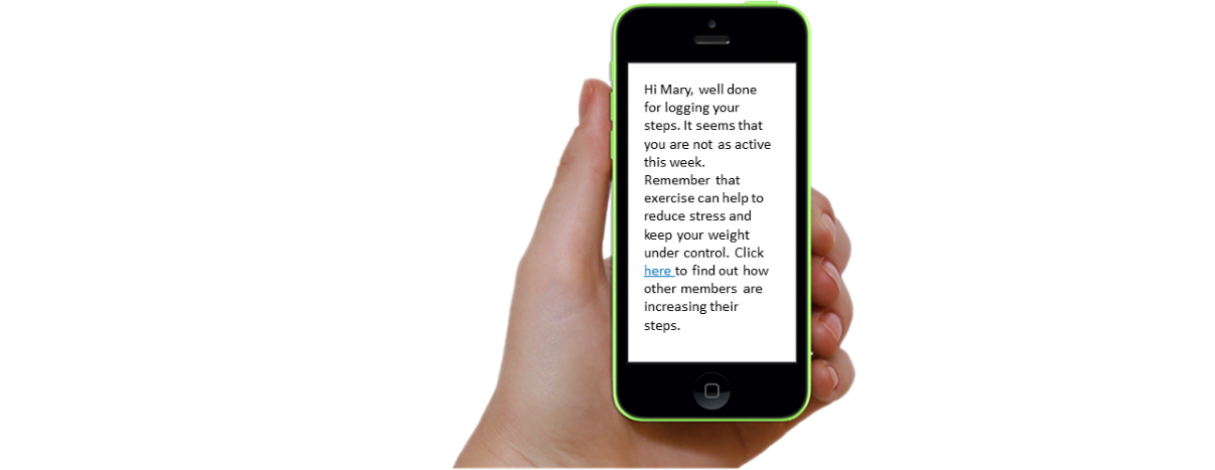
Figure 2. Example of physical activity feedback shown to participants for their